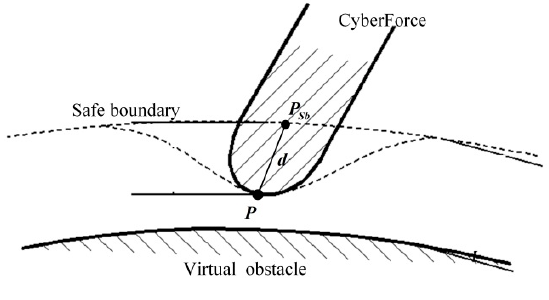
Figure 4. Distance of virtual obstacle.